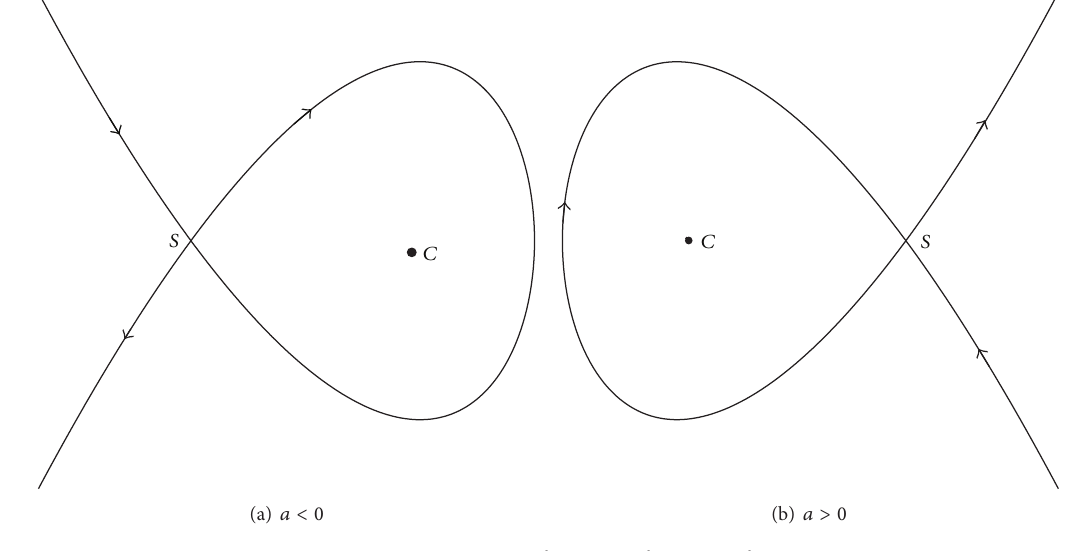
Figure 1: Level curves of (1/2)𝑦 2 + (1/3)𝑎𝑥 3 + (1/2)𝑏𝑥 2 + 𝑐𝑥 = ℎ